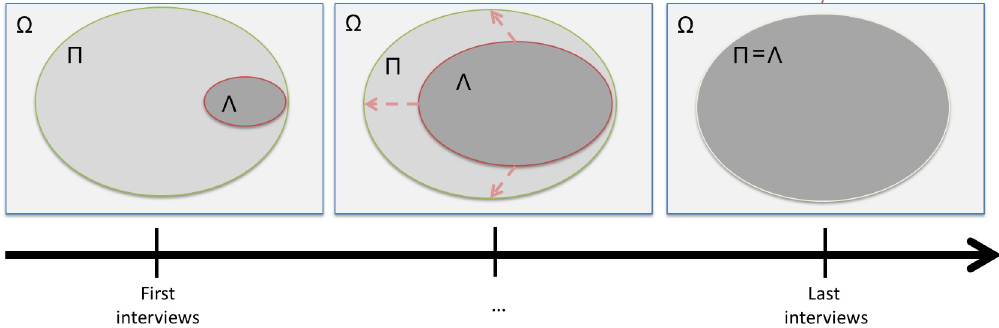
Fig 1. Schematic modeling of saturation in qualitative research using set theory. O = Universe of themes; P = Set of targeted themes; Λ = Set of relevant themes elicited during interviews.